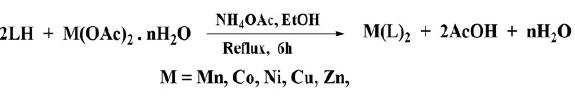
Figure 2. Proposed reaction for the synthesis of metal